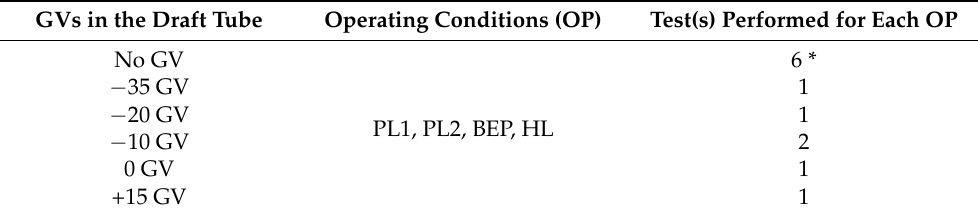
Table 3. Measurements performed. GVs in the Draft